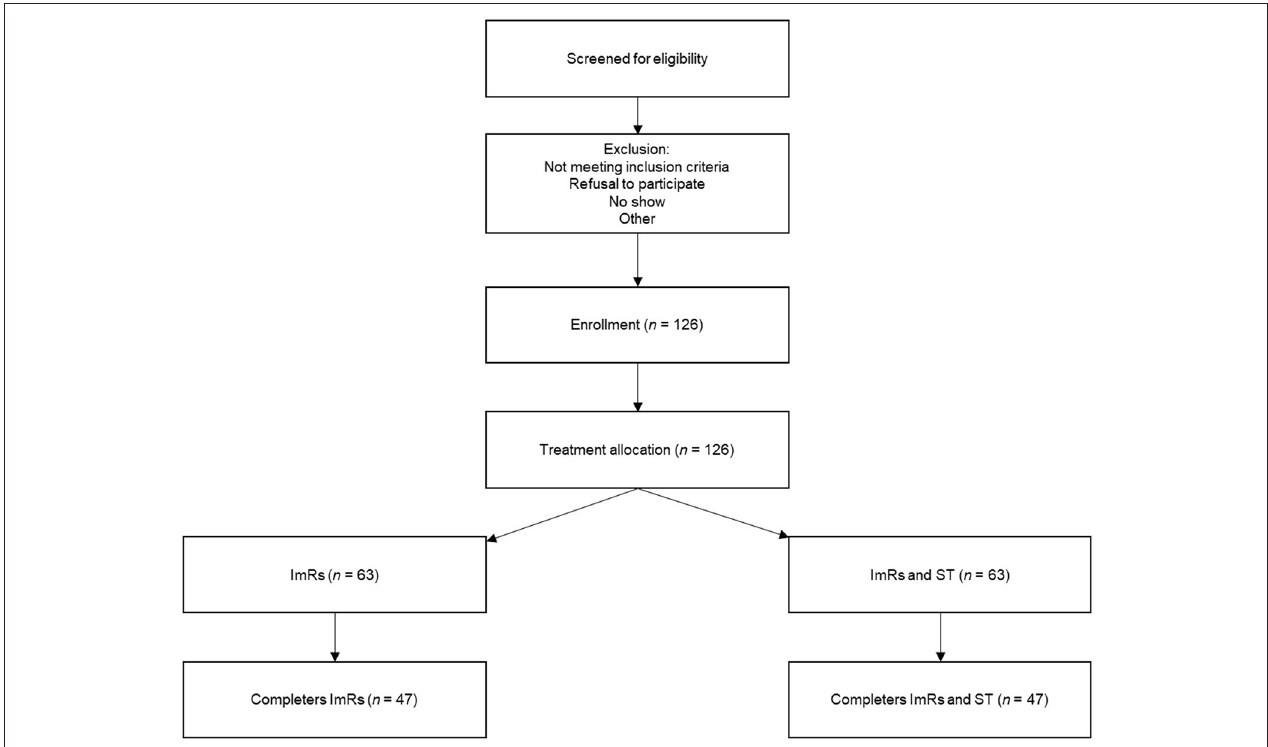
FIGURE 1 | Patient flow diagram displaying the participant selection process and expected number of